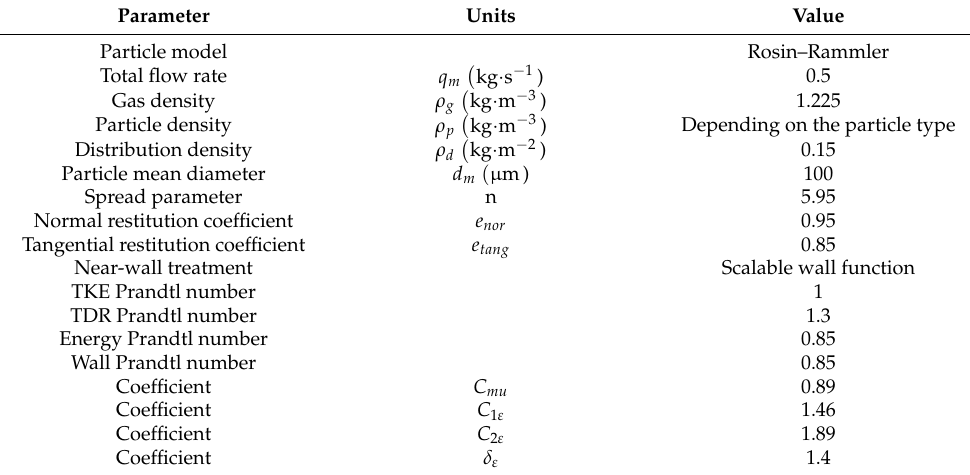
Figure 3. Mesh model of the regenerative air sweeper pickup head. Table 2. Simulation